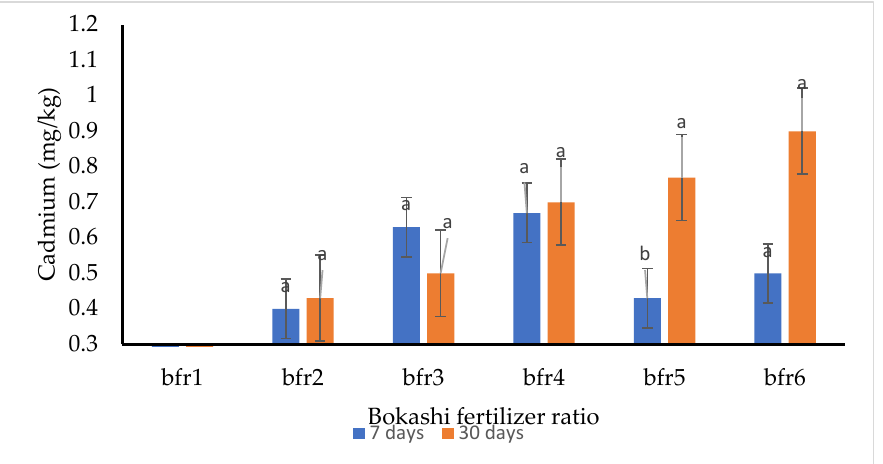
Figure 7. Interaction effects of bokashi fertilizer ratios and time of bokashi maturation (days) on the cadmium content. Bfr1 = (80% HBW:0% CD:20% PHC), bfr2 = (80% HBW:10% CD:10% PHC), bfr3 = (70% HBW:20% CD:10% PHC), bfr4 = (70% HBW:10% CD:20% PHC), bfr5 = (60% HBW:20% CD:20% PHC), bfr6 = (60% HBW:25% CD:15% PHC). HBW = horse bedding waste, CD = cow dung, PHC = paddy husk charcoal.